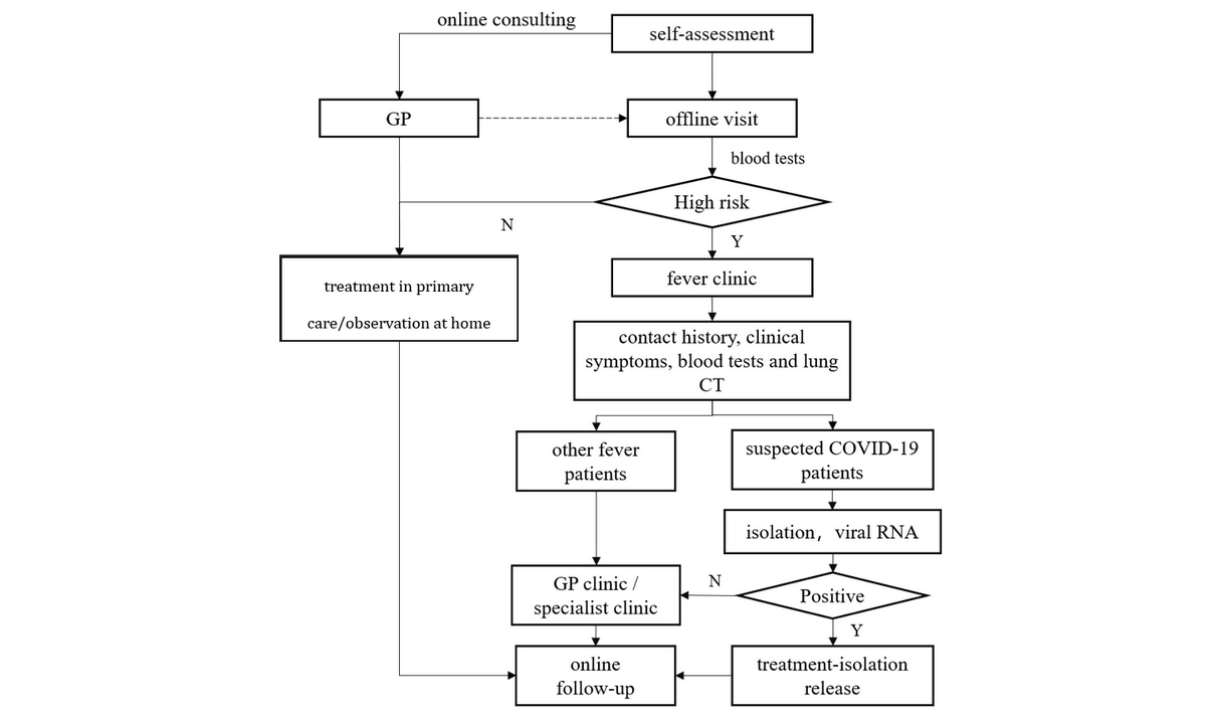
Figure 1. The covering scenes of patients using health care during the outbreak of COVID-19. COVID-19: coronavirus disease; CT: computed tomography; GP: general